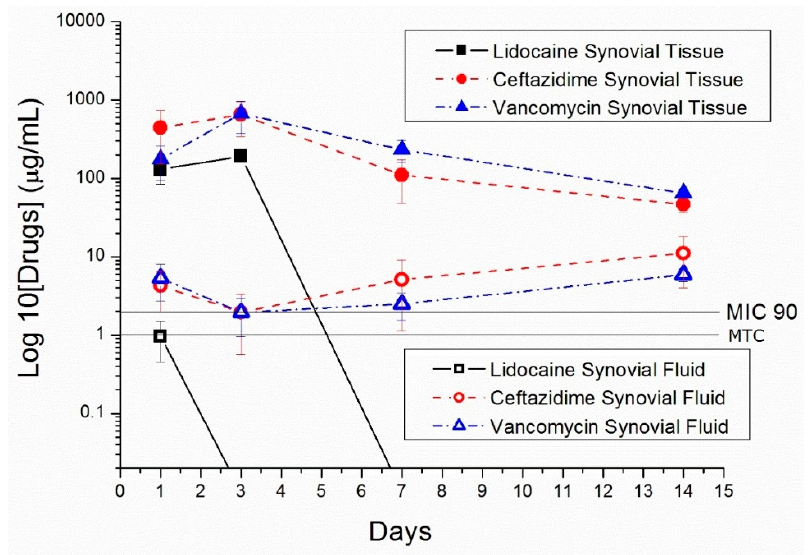
Figure 12. In vivo drug release curves of nano/microparticles in New Zealand white rabbits.